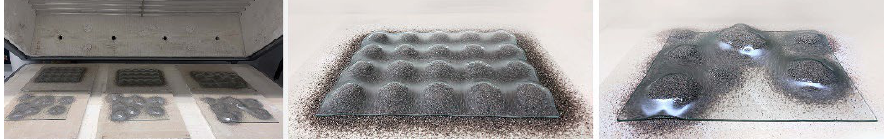
Fig. 6: Digital scan of sand mold deformation resulting from the slumping process. Deviations of +2mm to -2mm (visualized from red to blue).